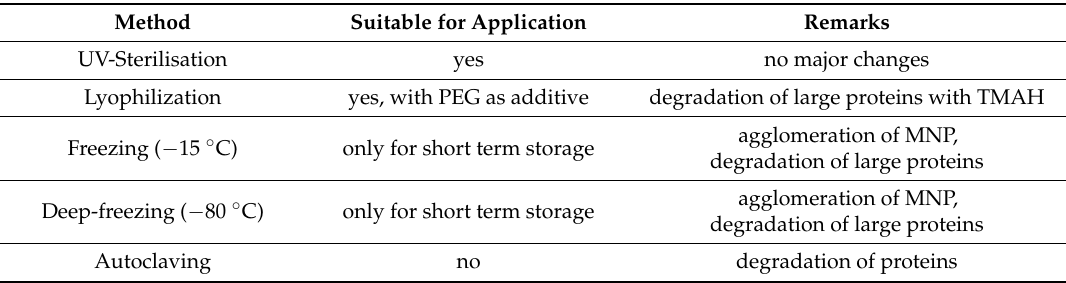
Table 2. Summary of treatment methods and their suitability for sterilization and preservation of protein-coated magnetic